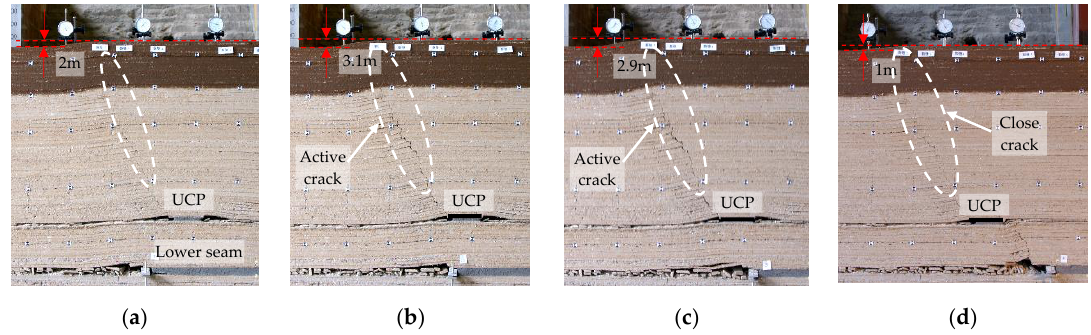
Figure 18. Distance from the center UCP: ( a ) 10 m, ( b ) aligned pillar, ( c ) 0 m, and ( d ) 40 m.